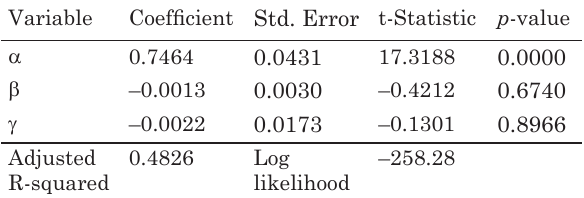
Table 3. Estimated results of ordinary least squares